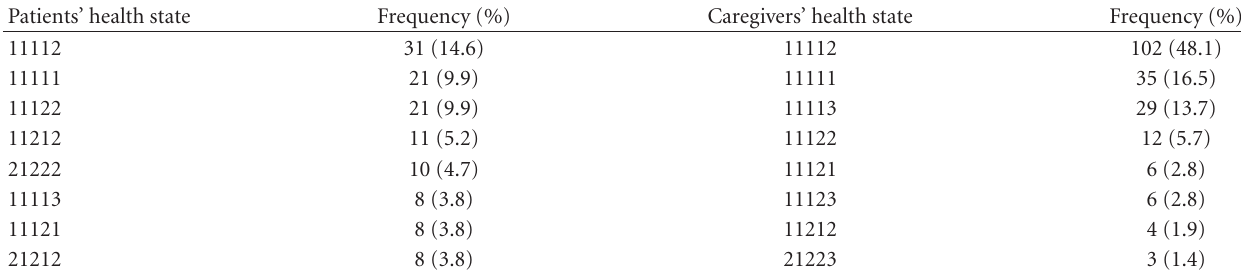
Table 5: The most prevalent health profiles of the patients and their